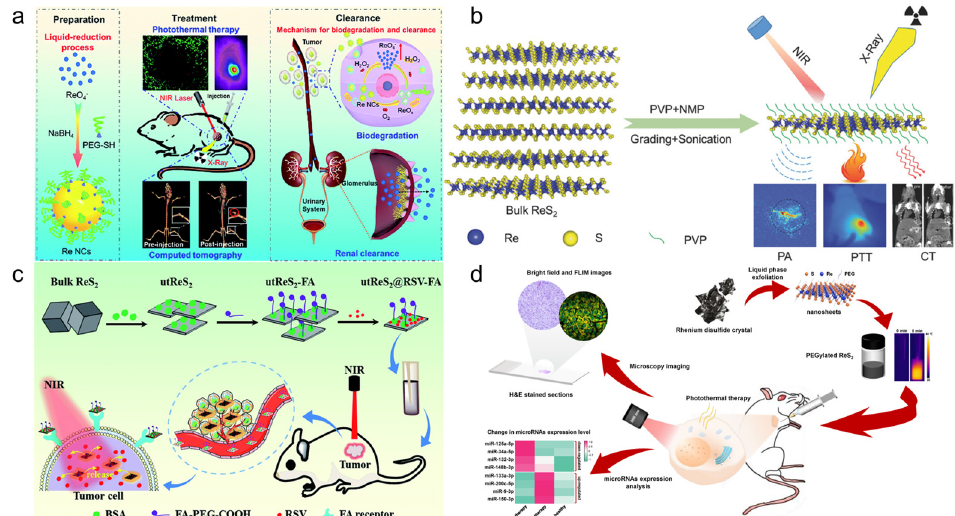
Figure 8. ( a ) Schematic of degradable and renal-clearable Re NCs for tumor diagnosis and therapy (reproduced with permission from Ref. [131], Copyright 2010, Royal Society of Chemistry); ( b ) scheme of the exfoliation process of PVP-capped ReS 2 nanosheets for bimodality PA and CT-imaging-guided photothermal therapy (reproduced with permission from Ref. [132], Copyright 2018, Wiley-VCH); ( c ) a schematic illustration of the utReS 2 @RSV–FA synthesis for tumor-targeted chemo-photothermal therapy (reproduced with permission from Ref. [135], Copyright 2011, Royal Society of Chemistry); ( d ) schematic illustration of PEG − ReS 2 nanosheets employed for in vivo breast cancer therapy study (reproduced with permission from Ref. [134], Copyright 2022, MDPI). NCs, nanoclusters; PVP, polyvinyl pyrrolidone; CT, computed tomography; PA, photoacoustic imaging; PEG, polyethylene